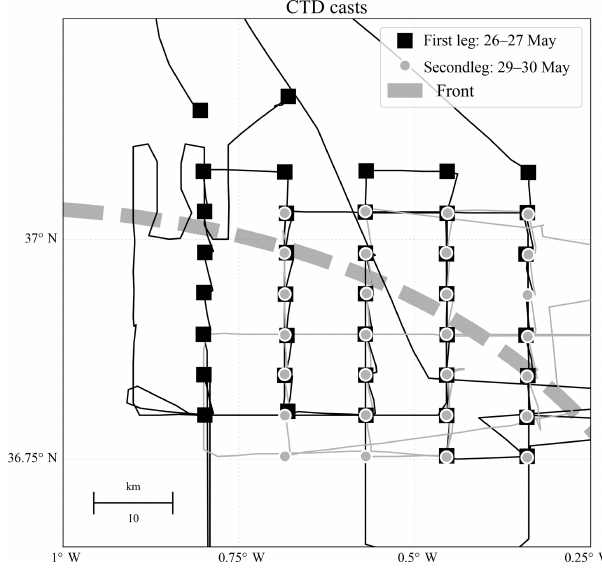
Figure 3. The CTD casts were organised into five legs that crossed the front and were repeated over two periods, at the beginning and the end of the